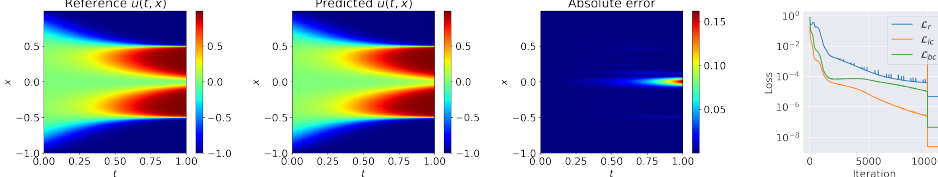
Figure 4. cSPINNs results (with ResNet block-enhanced) for solving 1D Allen–Cahn